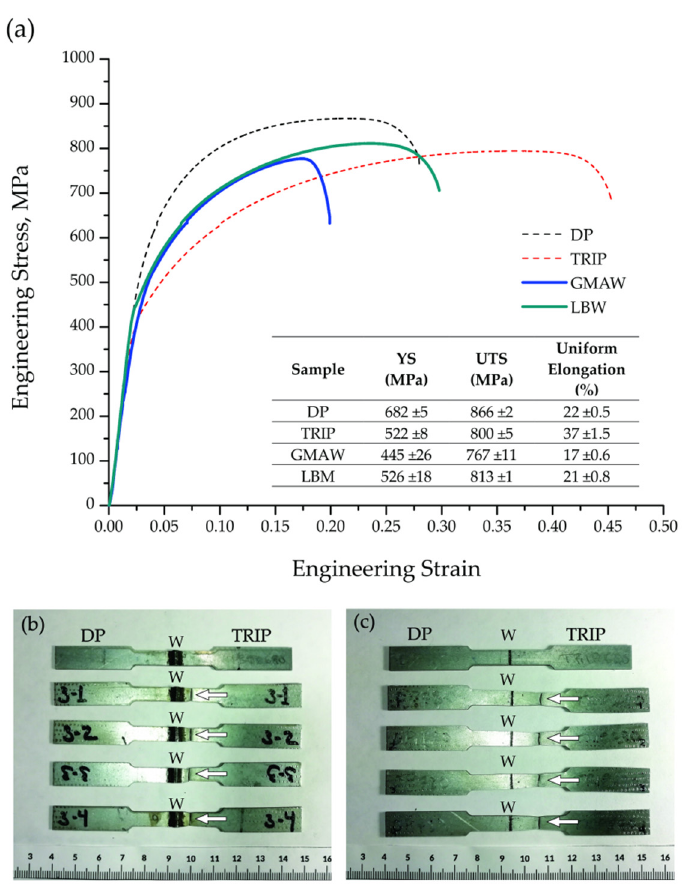
Figure 10. ( a ) Engineering stress-strain properties for base metal and welded specimens, and failure location (as indicated by the arrow) for ( b ) GMAW specimens, ( c ) LBW specimens. An untested specimen is added as a benchmark.